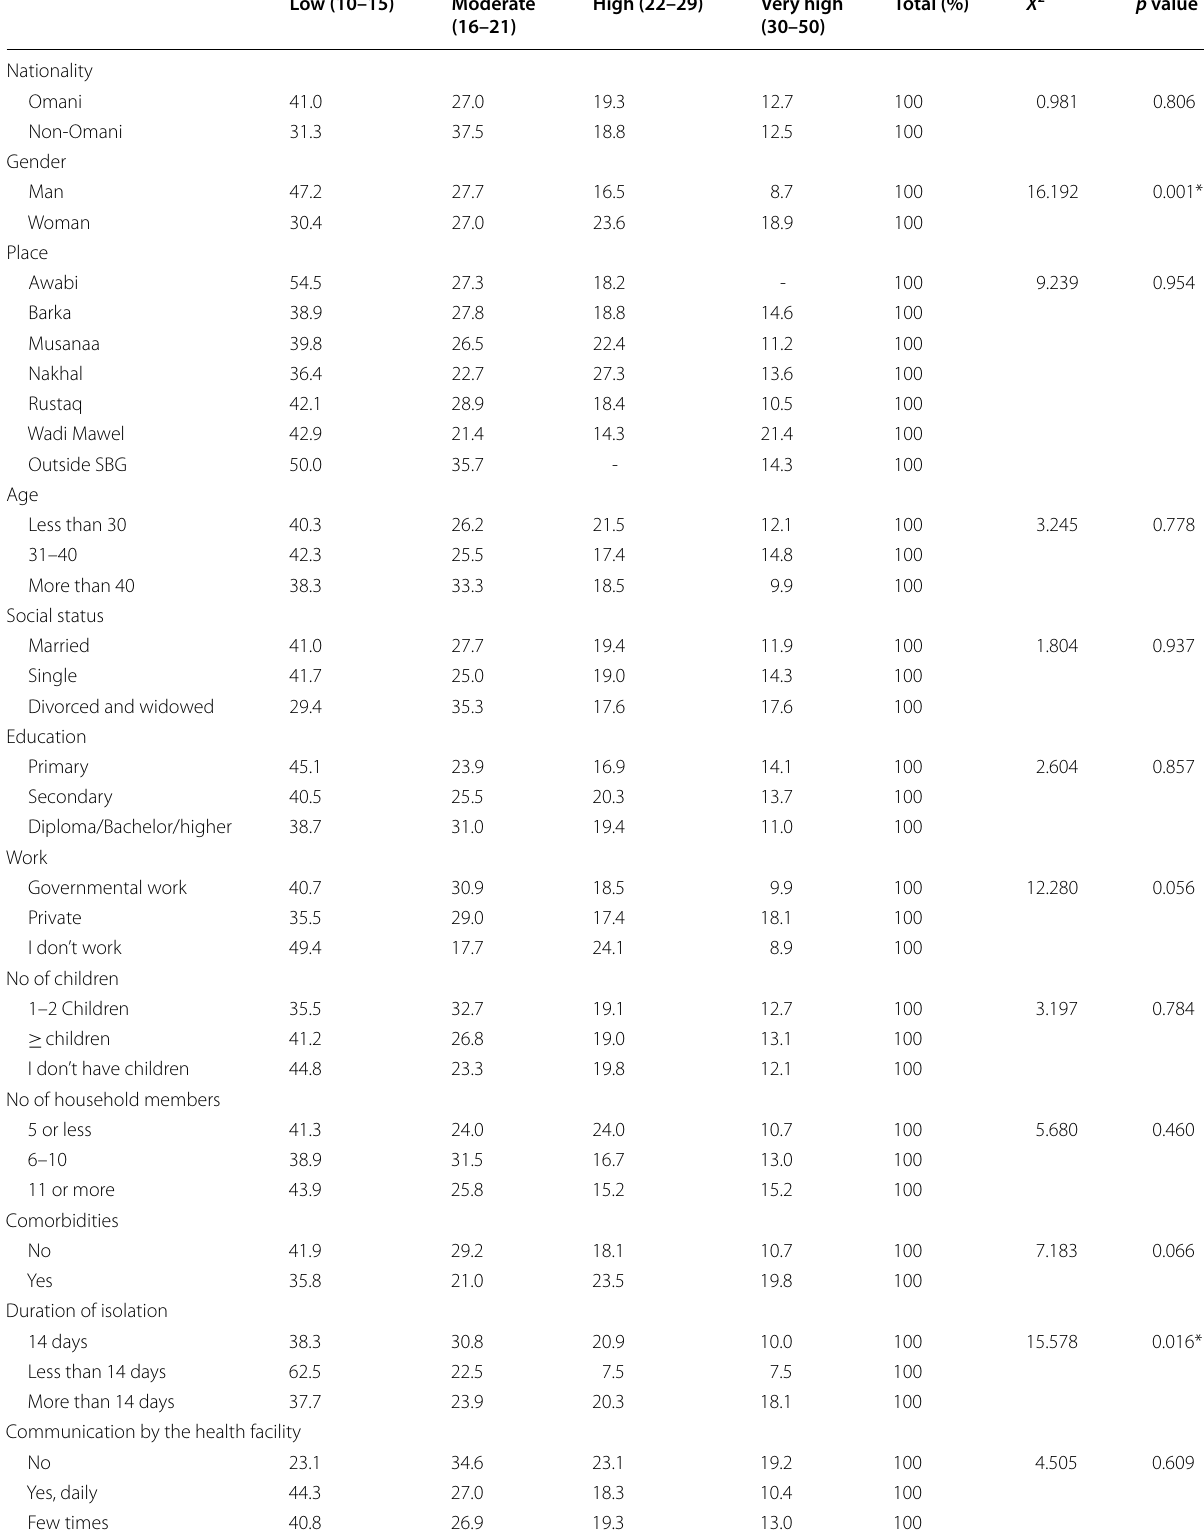
Table 3 Relationship between Kessler categorical scales and patients’